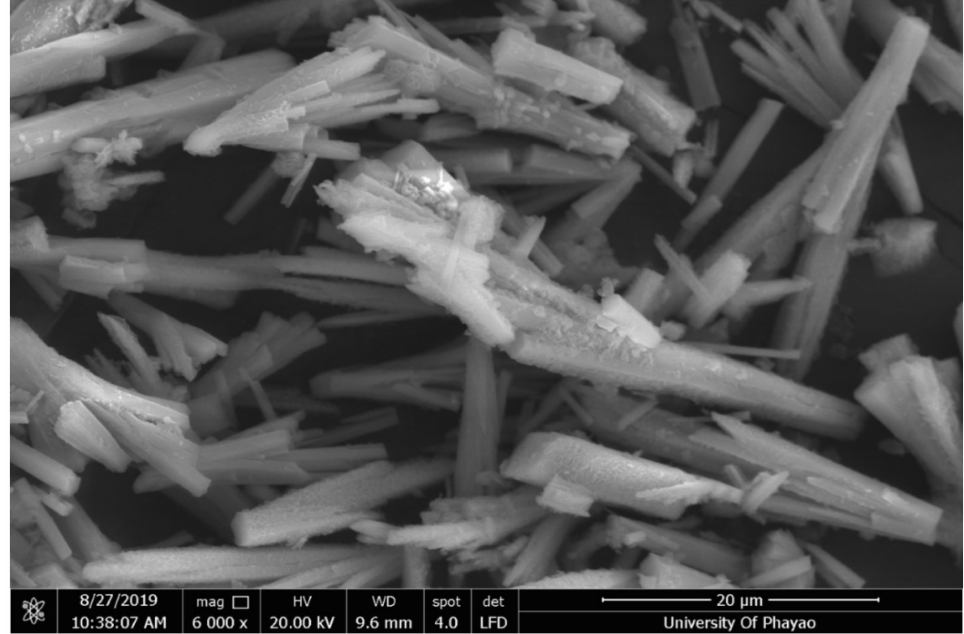
Figure 1. Phusang hot spring powder at 180 ◦ C.